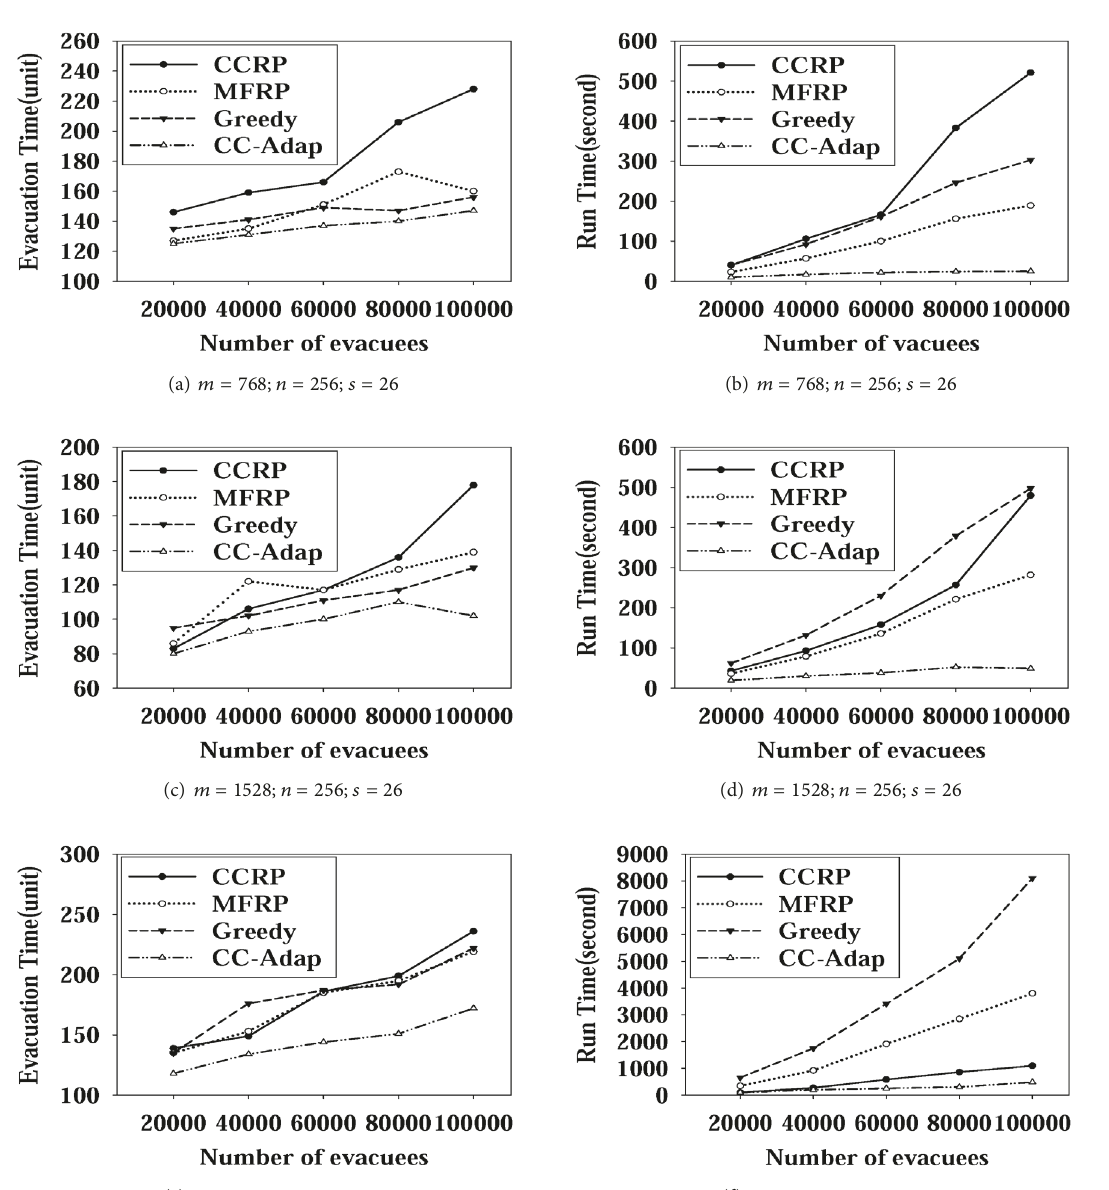
Figure 7: Evacuation quality with respect to the number of